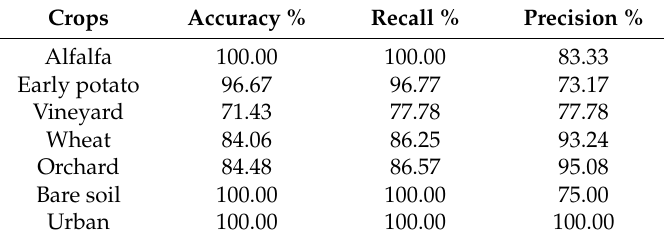
Table 4. Validity of the crop classification (spring